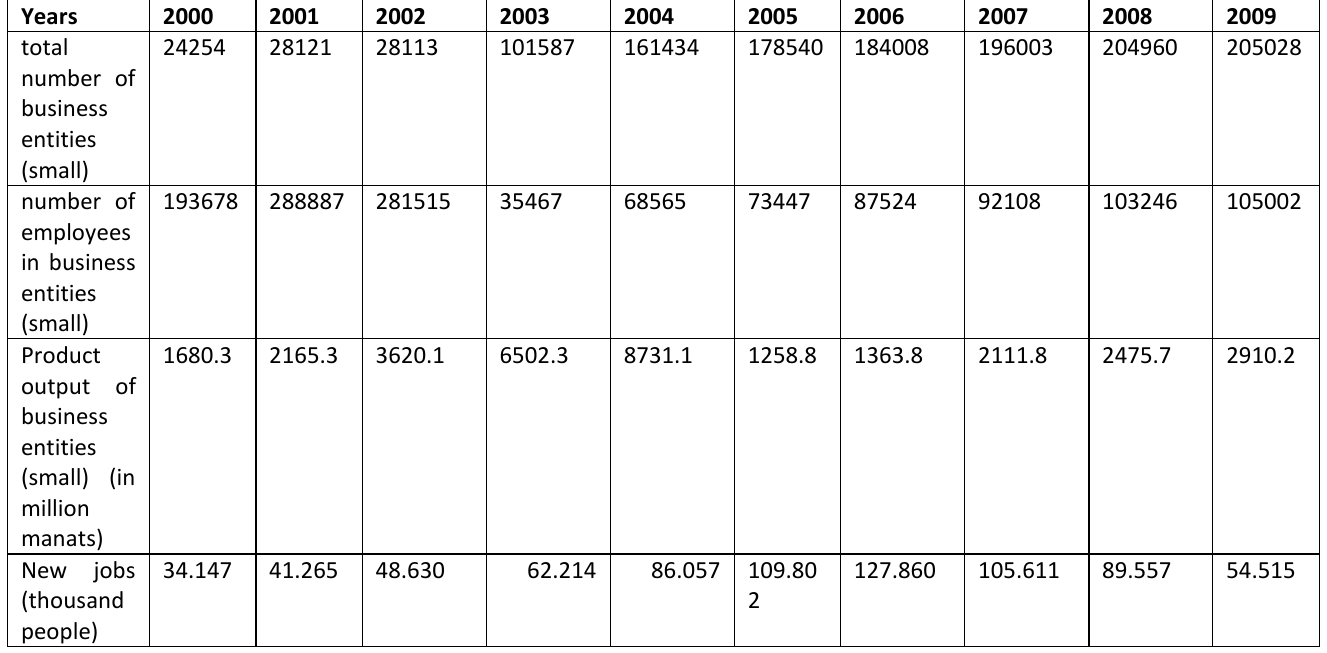
Table 1. The main indicators of small and medium enterprises in the